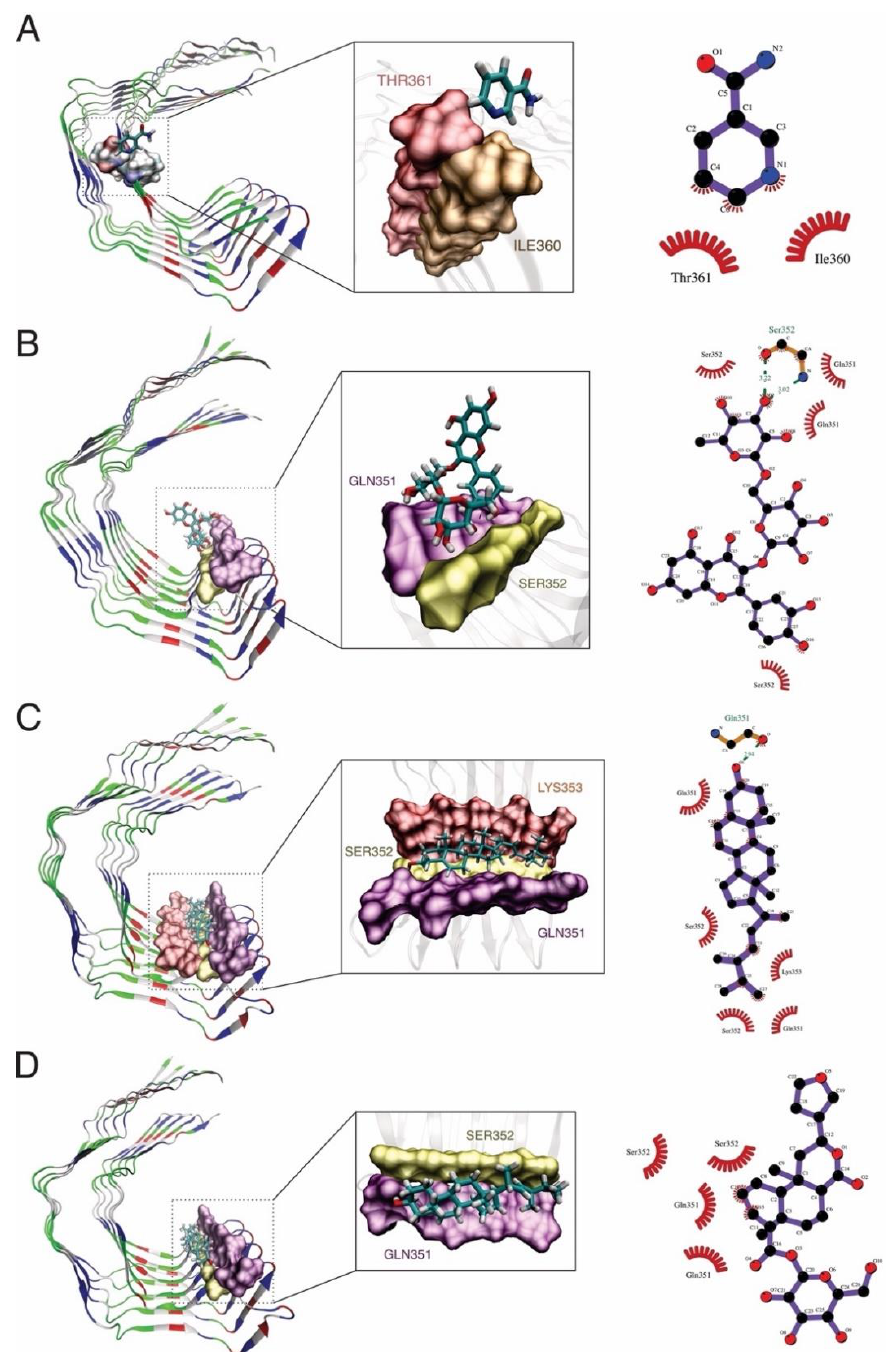
Figure 5. MD simulation and docking analysis shows the formation of hydrogen bond interactions between the tau protein and: ( A ) nicotinamide, ( B ) rutin, ( C ) brassicasterol, and ( D ) floribundic acid binding interactions between the ligand and receptor.